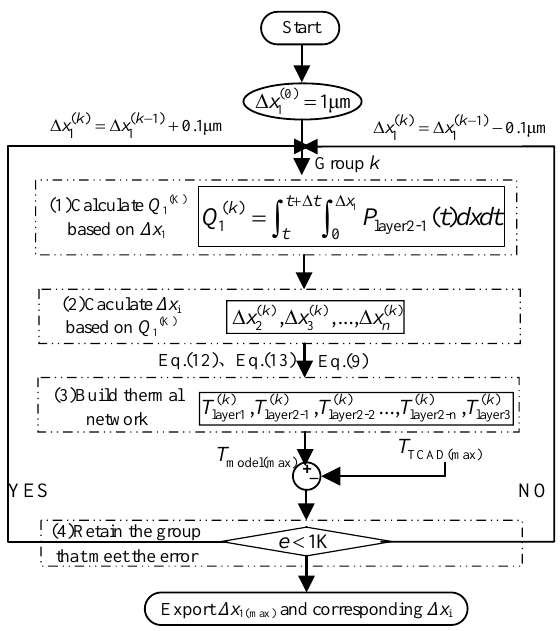
Figure 4. Sublayer division strategy flow chart.